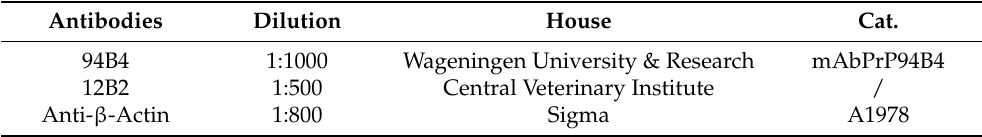
Table 2. Primary antibodies used for WB